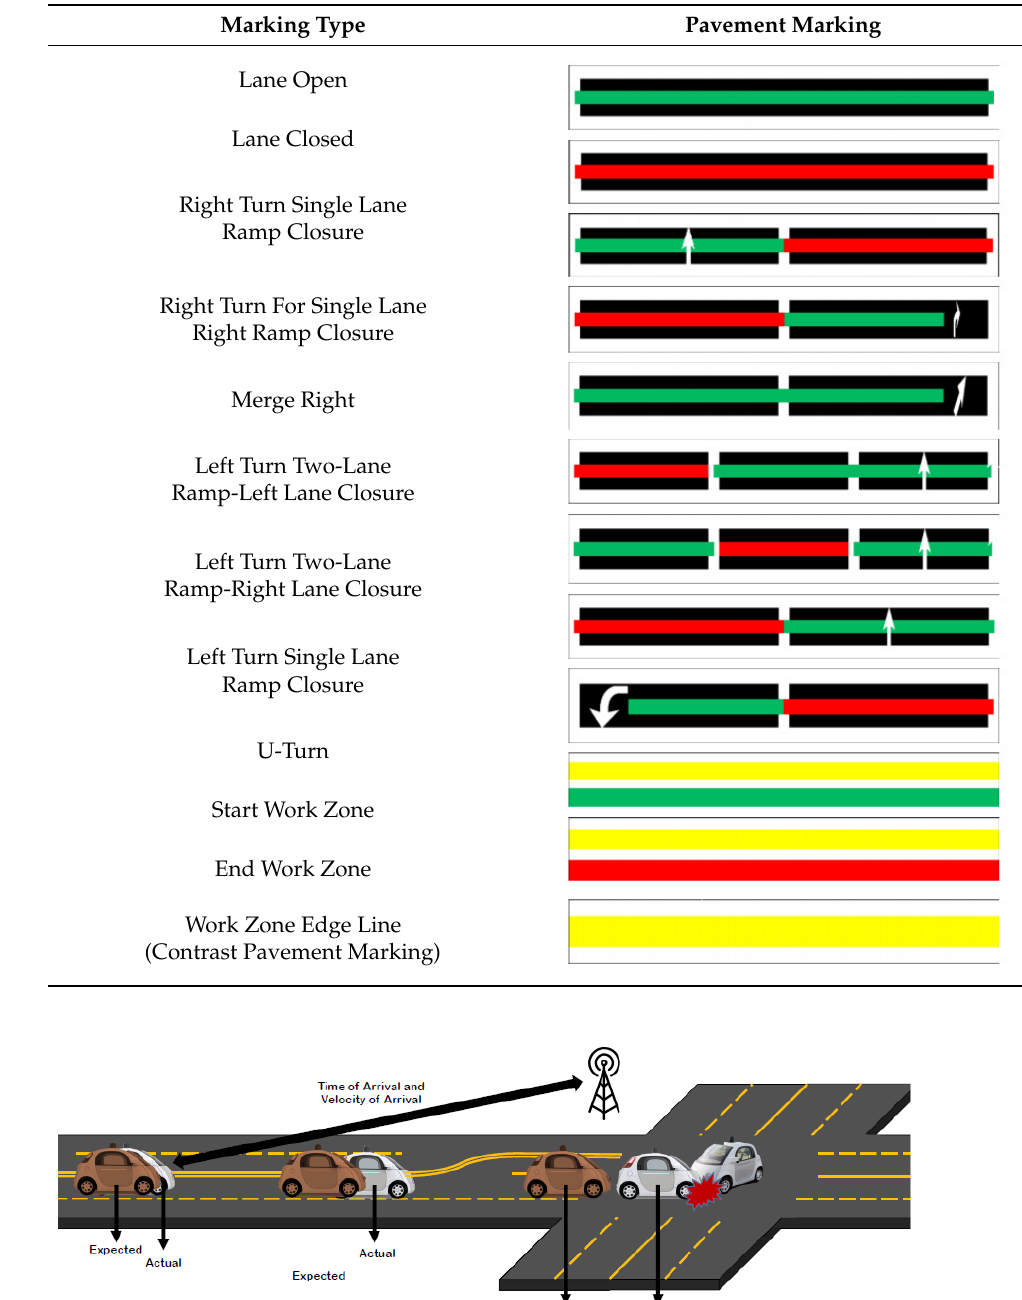
Table 3. New markings for AVs movement in work areas [28].